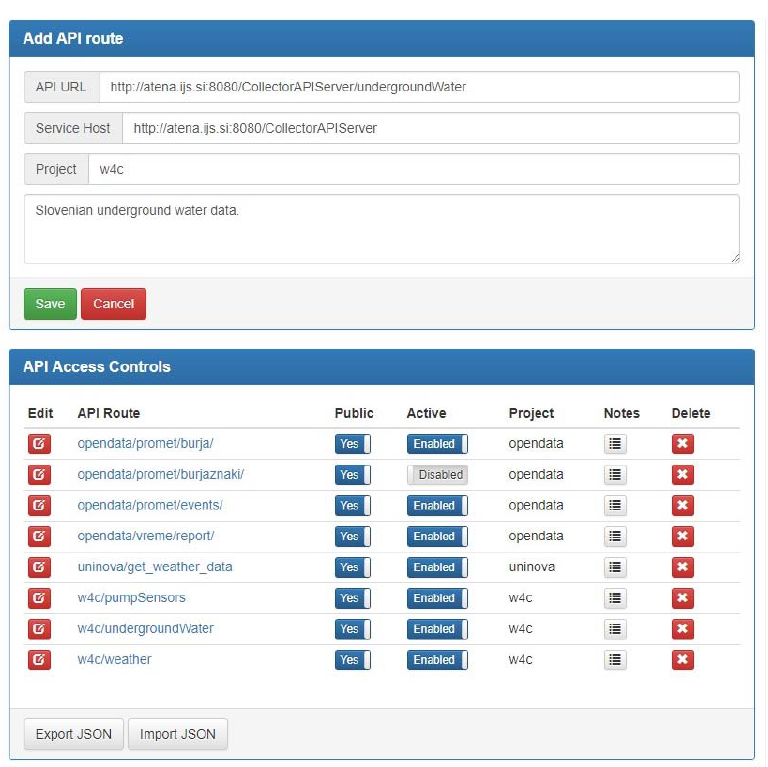
Figure 2. API Management tool web interface—User management.